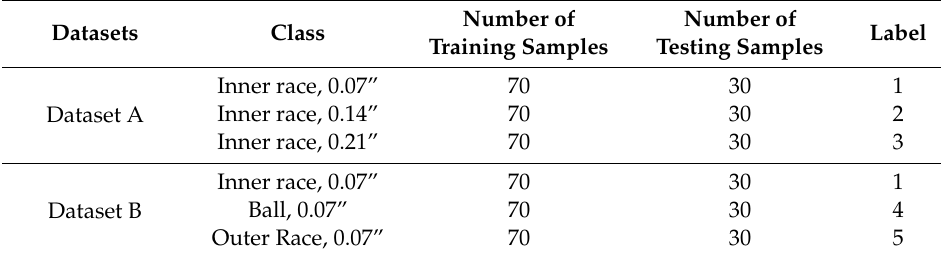
Table 1. Description of dataset.